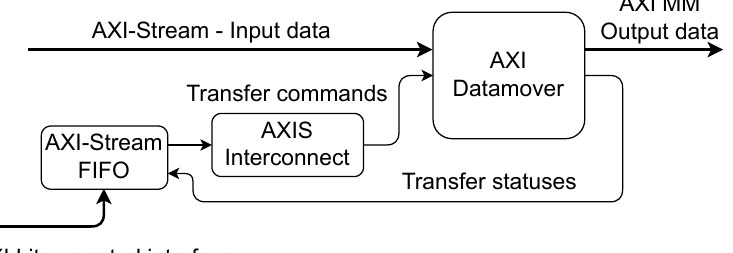
Figure 4. Block diagram of the DMA engine based on AXI Datamover. The driver delivers the transfer commands (with data of consecutive contiguous buffers) through the AXI FIFO MM [21] block. The AXI Interconnect block concatenates a few words in a single data transfer command. The statuses of the transfers are sent back to the AXI-Stream